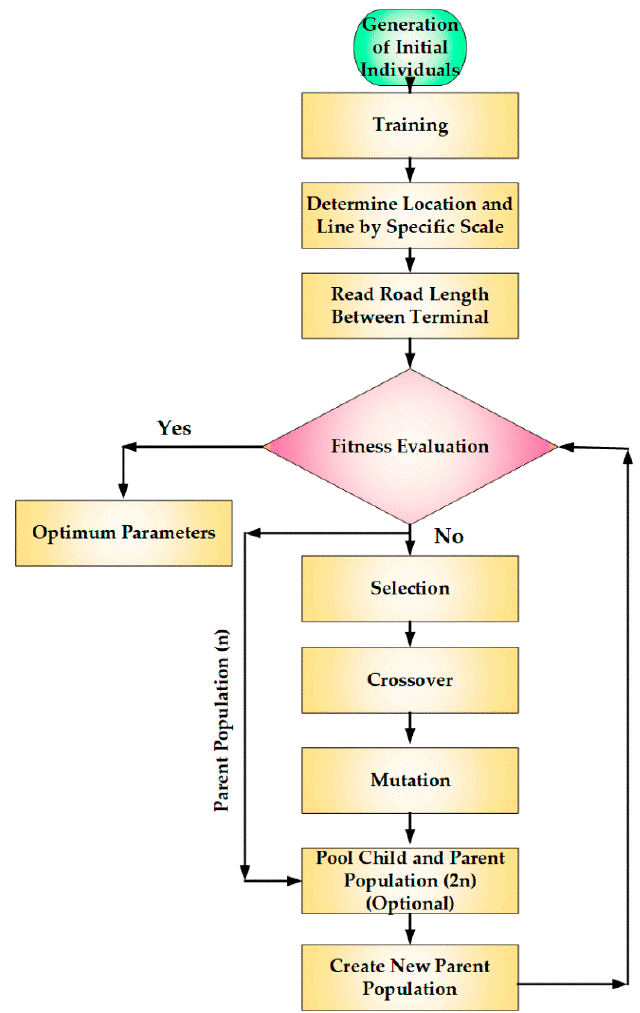
Figure 10. Flow chart of Genetic Algorithm (GA) estimation method. Table 3. Chromosome structure for aforementioned locations with their corresponding areas (termed as B, C, and D).